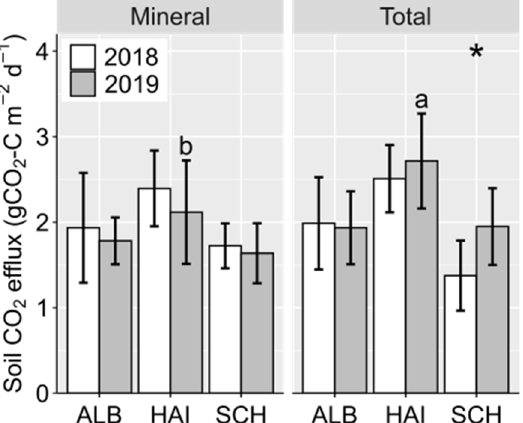
Figure 3. Total and mineral in situ soil CO 2 efflux for a subset of 29 forest sites out of the 150 forest sites of the Biodiversity Exploratories project. Bars represent mean values, and the error bars represent standard deviations. Lower case letters indicate differences between total and mineral soil CO 2 efflux for a given study region in 2019. Asterisks indicate significant differences between the years for a given study region.